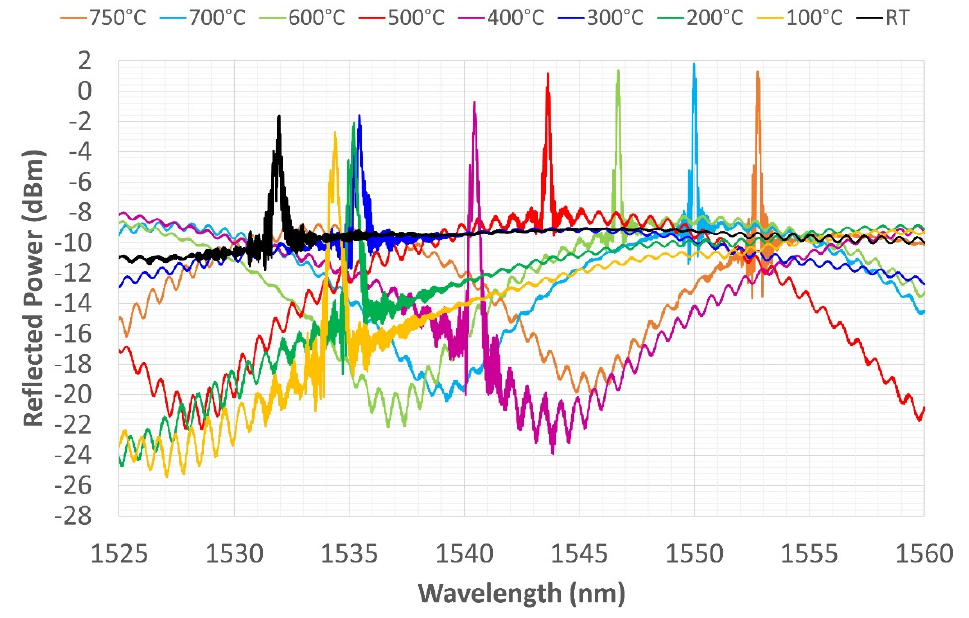
Figure 11. Second thermal cycle—grating reflected spectrum change during heating from 750 °C to RT.